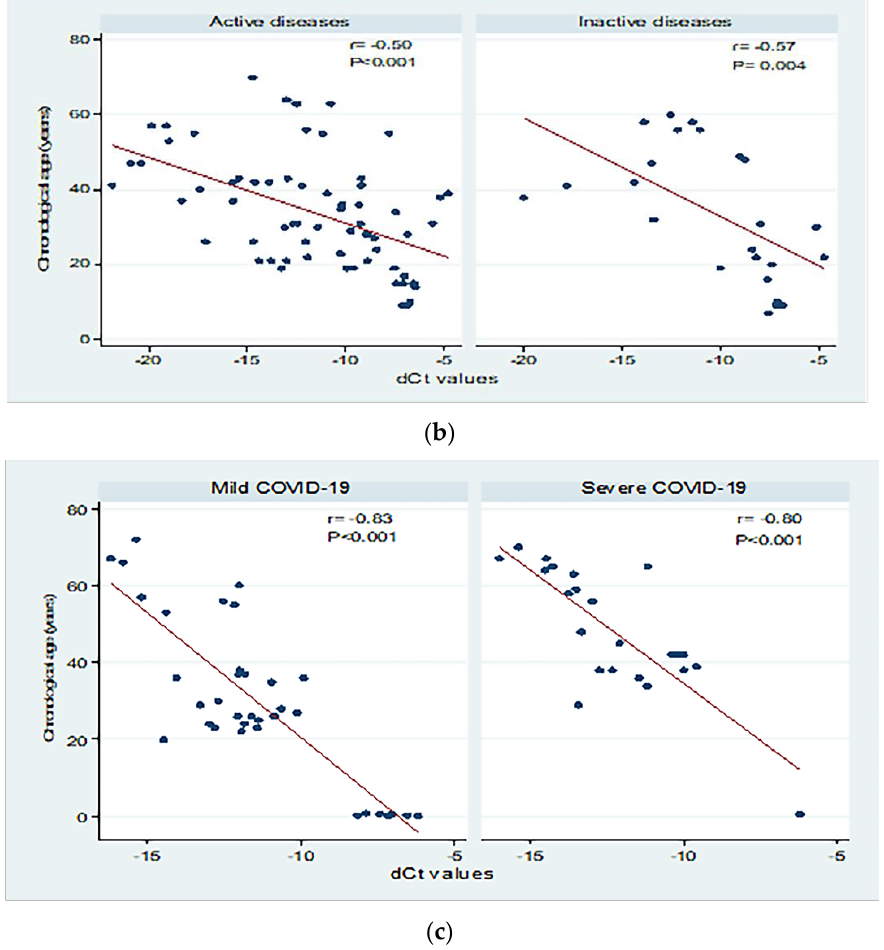
Figure 3. Correlations between chronological age (in years) and dCt (CtTBP−CtsjTREC) values among healthy individuals, autoimmune patients, and COVID ‒ 19 patients ( a ), patients with active and inactive autoimmune diseases ( b ), and COVID ‒ 19 patients with different disease severity ( c ). r: Pearson correlation coefficient; p : probability, significant correlations at p < 0.05.